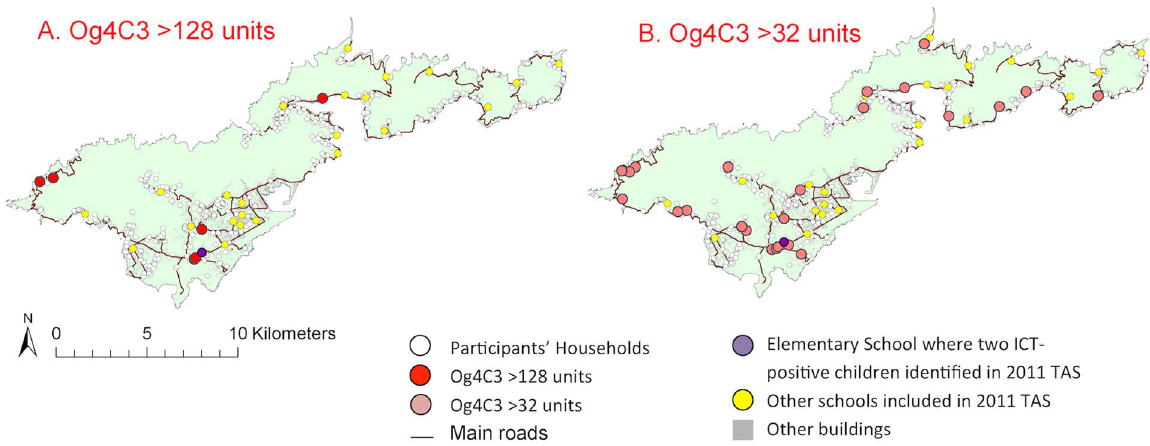
Figure 5. Household locations of individuals with positive and negative antigen on Tutuila. A. Og4C3 . 128 units, B. Og4C3 . 32 units.